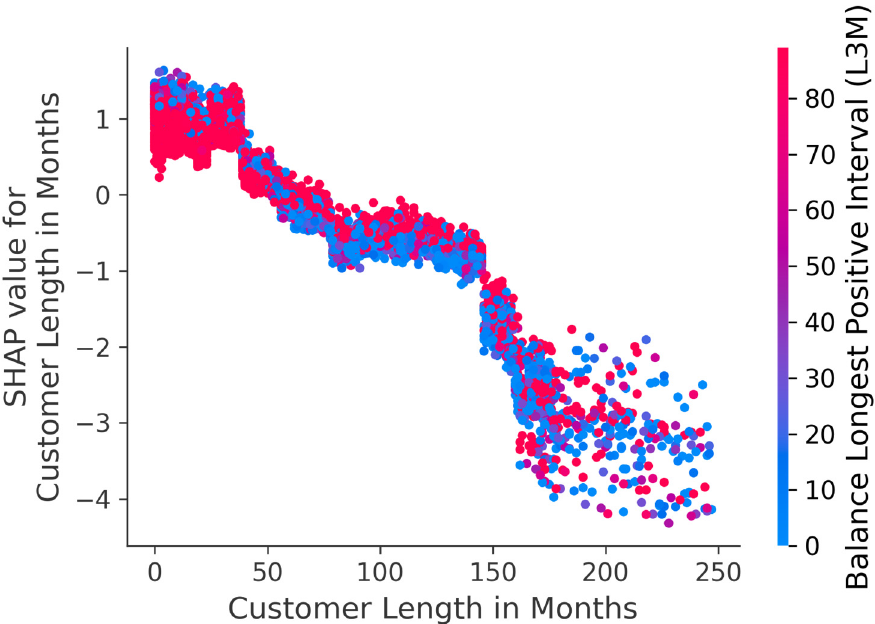
Figure 9. SHAP dependence plot showing SHAP values for Customer Length in Months , color-coded based on the value of the Balance Longest Positive Interval (L3M) feature. Each dot represents one customer and positive SHAP values are associated with an increase in default probability.